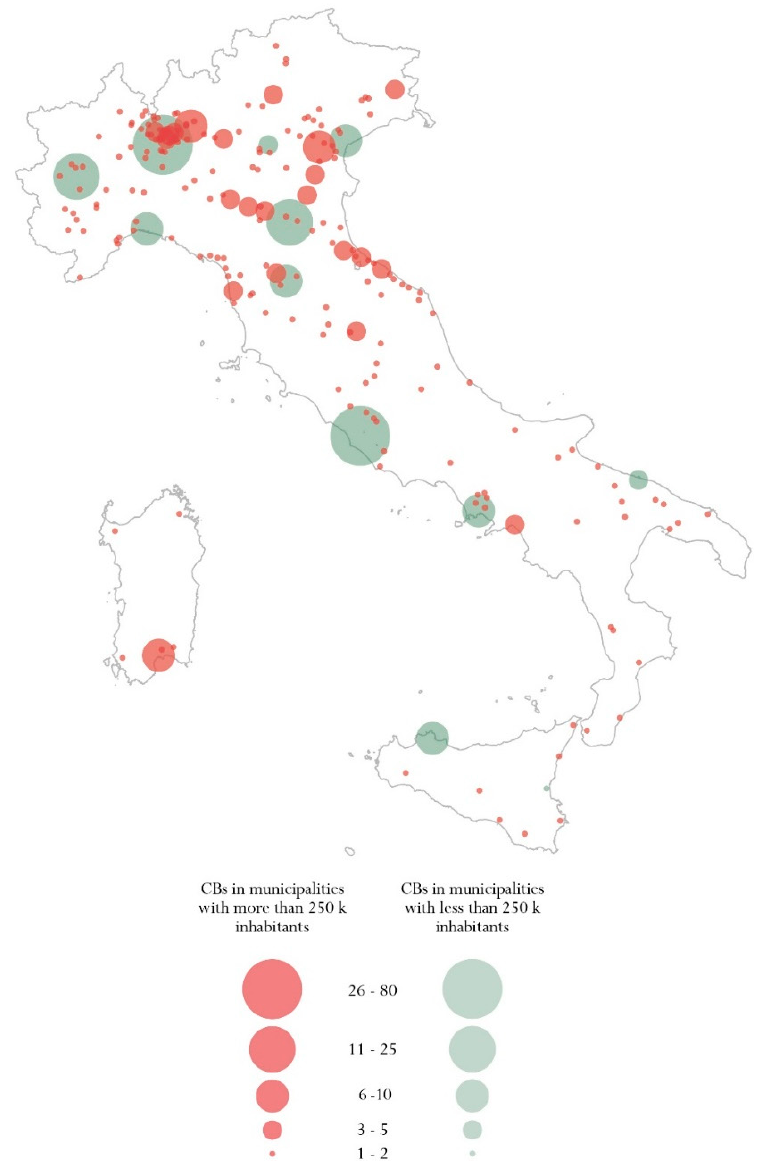
Figure 1. Map of CBs by municipality.